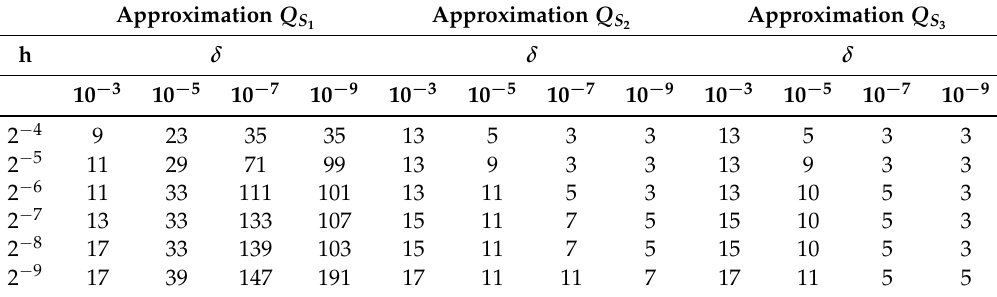
Figure 2. Ordered eigenvalue distributions of Q − 1 1 × 10 − 3 , δ = 1 × 10 − 5 and δ = 1 × 10 − 7 with h = 2 − 4 . Table 3. Number of iterations made by MINRES solver with the block diagonal preconditioners Q Q Q 2 , 3 with Schur compliment approximated by Q S 1 , Q S 2 , Q S 3 for different values of h and δ , 1 , tolerance = 10 − 6